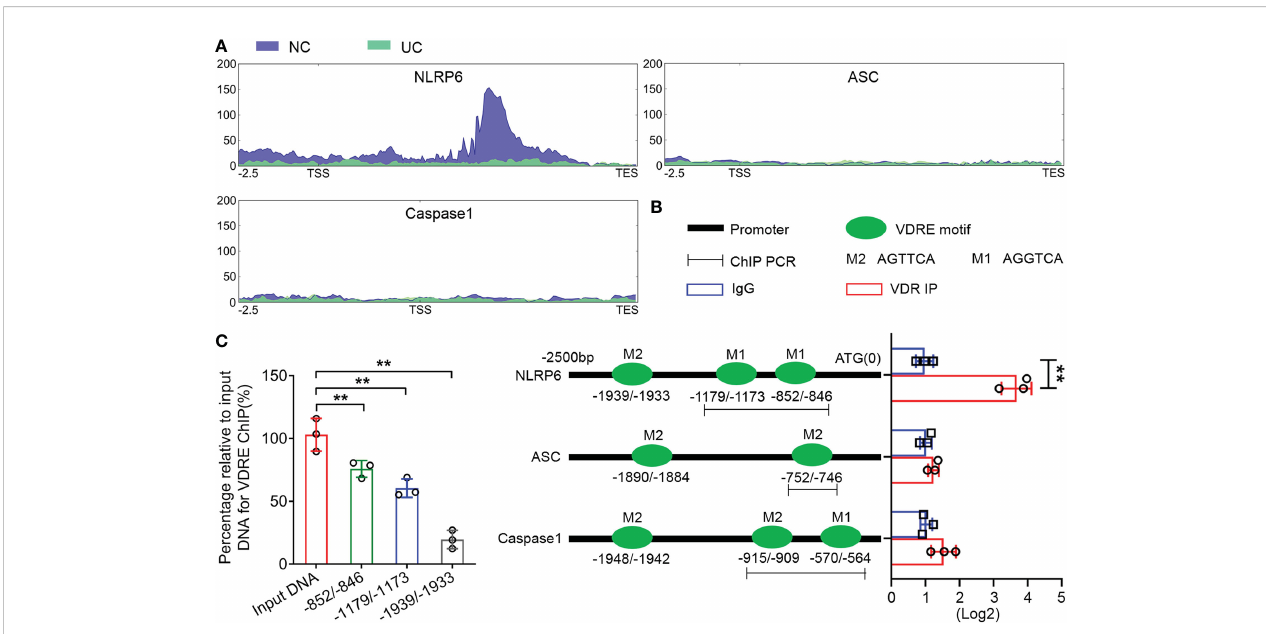
FIGURE 5 VDR downregulates NLRP6 expression by inhibiting the transcriptional activity of the NLRP6 promoter. (A) ATAC-seq enrichment from 2500 bp upstream of the TSSs throughout the whole ranges of the NLRP6, ASC and Caspase-1 genes in normal and UC tissues. (B) Presence of the AGTTCA and AGGTCA motifs in the promoters of NLRP6, ASC and Caspase-1 (left) and qChIP-PCR results (right) showing the binding of VDR to the promoter fragments containing the AGTTCA and AGGTCA motifs in the promoters of NLRP6, Caspase-1 and the AGTTCA motifs in the promoters of ASC, respectively. (C) The percentage relative to the input for the enriched fragments of the VDRE ChIP. The data are shown as the mean ± SD, n ≥ 3, ** P < 0.01